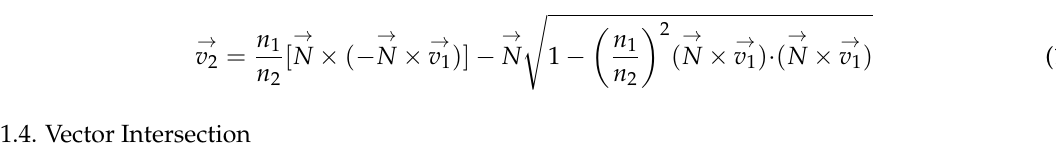
In a generalized three-dimensional expression of Snell’s law (Figure 3), the border